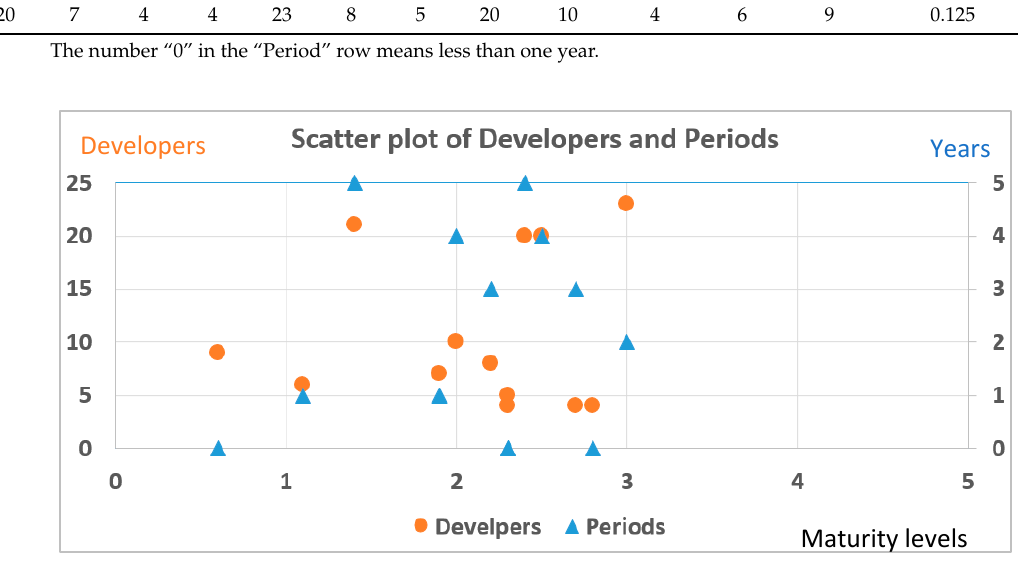
Figure 4. Maturity levels, development periods, and number of developers of 13 AI projects (Graph). Pearson coefficient R = 0.125 (Developers), R = 0.107 (Periods). We also check the correlations of the development periods and the number of develop- ers with the maturity levels with respect to each process. As shown in Table 9, all processes have a Pearson coefficient of 0.444 or less, which means there is no special correlation. Table 9. Correlation of development periods and the number of developers w. r. t. each process.